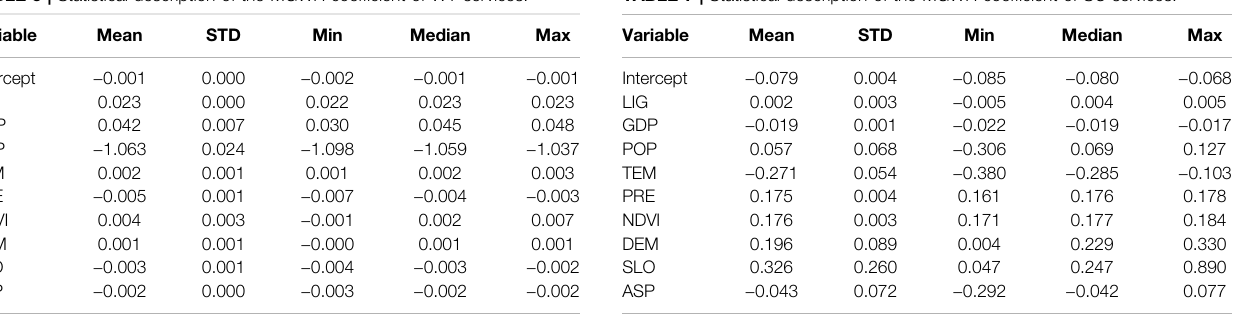
TABLE 7 | Statistical description of the MGWR coef fi cient of SC